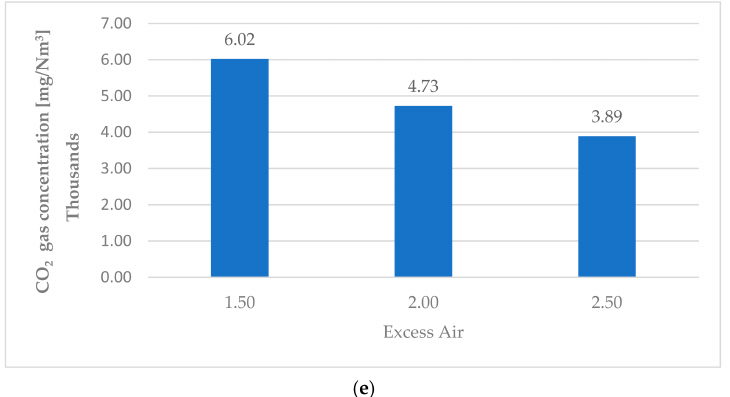
Figure 9. Emission concentrations (SO 2 , NO 2 , HCL, and CO 2 ) before and after the treatment process as a function of excess air. ( a ) Excess air 1.5. ( b ) Excess air 2. ( c ) Excess air 2.5. ( d ) CO 2 emissions before exposing to reduction process. ( e ) CO 2 emissions after exposing to reduction process.